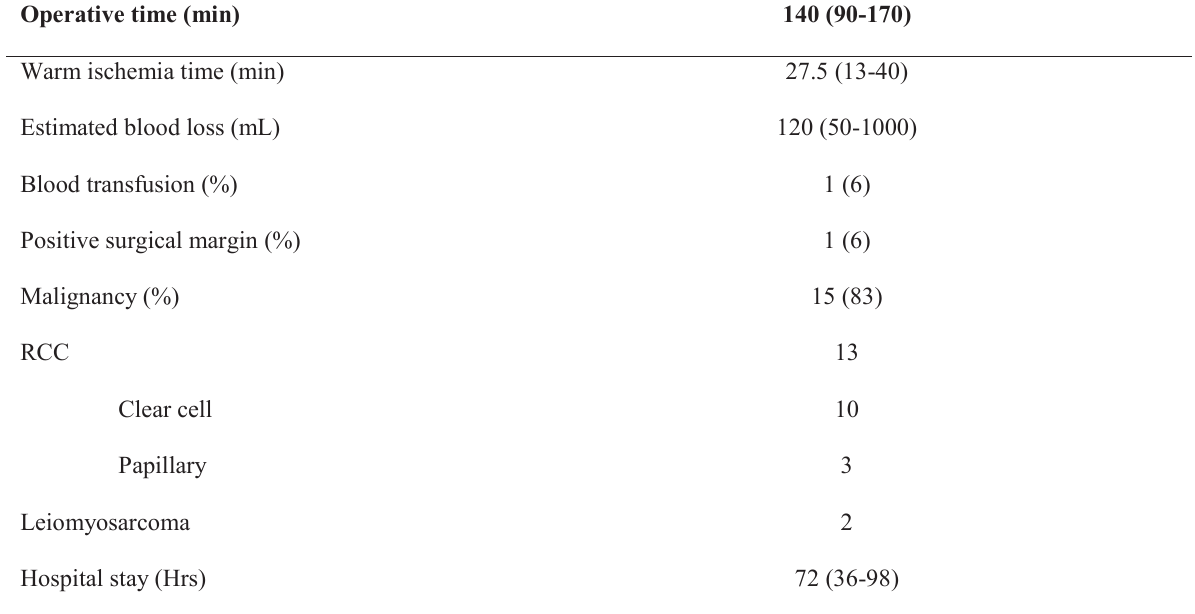
Table 2 - Perioperative outcomes Pathological results .